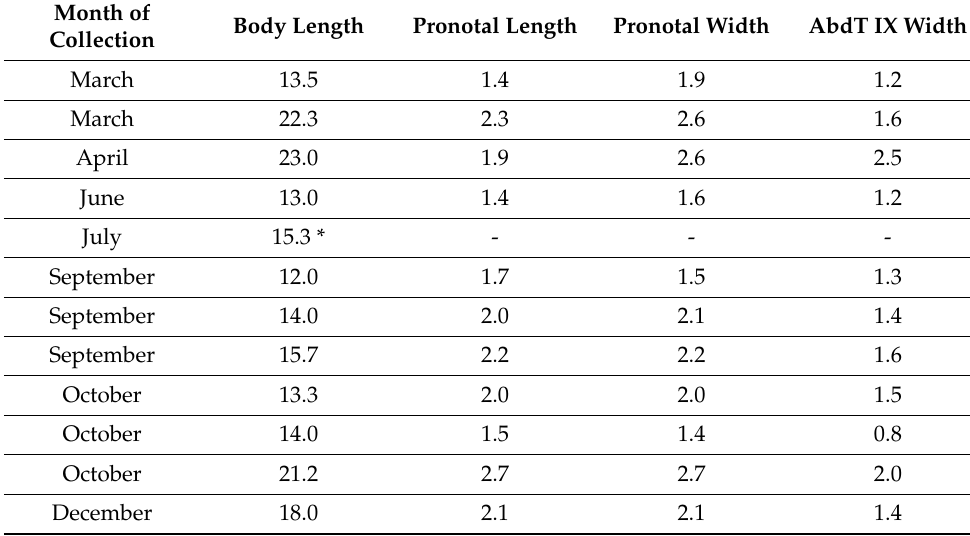
Table 1. Collection of larval A. monachus arranged by months (n = 12). Measurements are in millimeters. AbdT IX-abdominal tergite IX; *—taken from